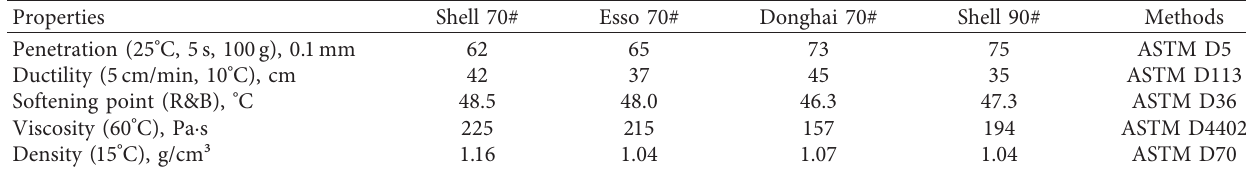
Table 1: Properties of asphalt binders.